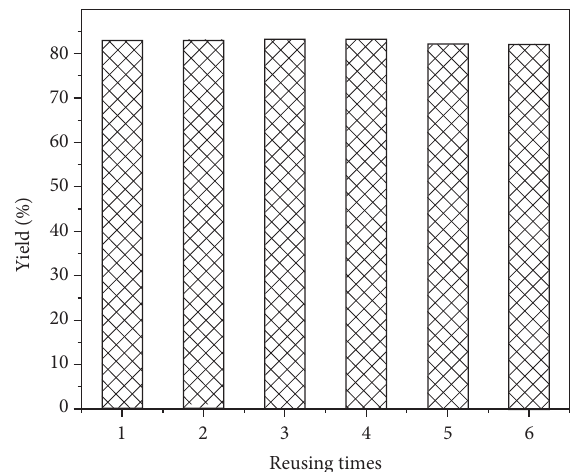
Figure 7: Reusability of [Bmim]ZnCl 3 in the glycolysis of PET. 5 h, and temperature 180 ∘ C. Table 2: Glycolysis of different PET products catalyzed